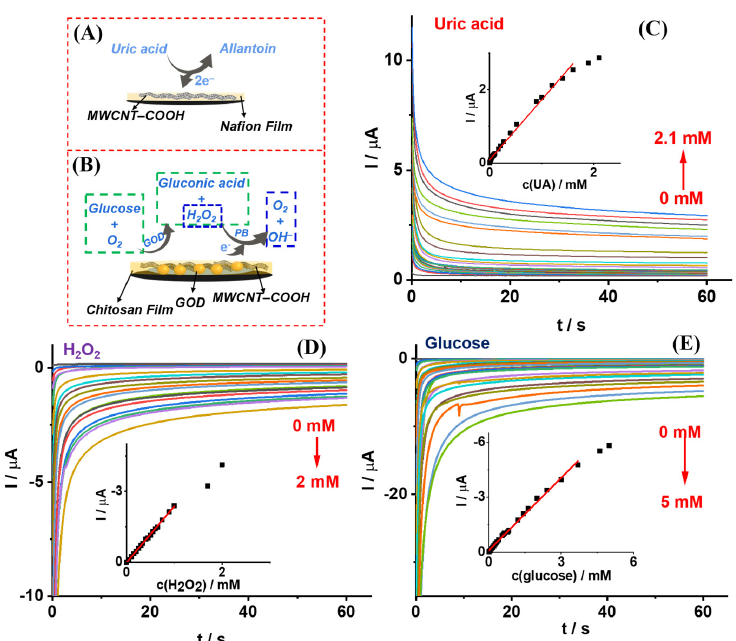
Figure 4. The electrochemical sensing performance of the dual function sensor in 0.1 M PBS, pH 7.4. ( A , B ) Schemes of Sensor-UA and Sensor-glucose’s electrochemical reaction mechanism towards UA and glucose, respectively. ( C – E ) Chronoamperometric response of Sensor-UA, PB/WE and Sensor- glucose towards UA, H 2 O 2 and glucose, respectively. The insets show the corresponding calibration curves with linear fitting, n = 3. The applied potentials were 0.12, 0.03 and 0.03 V, respectively. All of the recording times were 60 s.